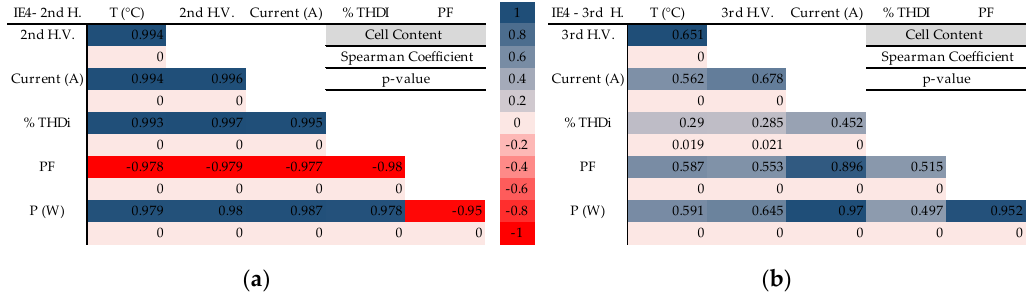
Figure 16. Correlation matrix between temperature and input parameters in IE4 class LSPMM for ( a ) second harmonic voltage distortion; ( b ) third harmonic voltage distortion.